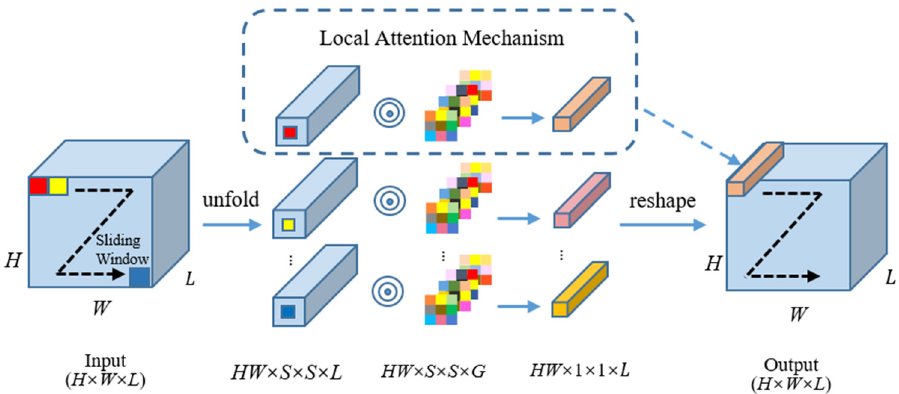
Figure 3. Structure of the LAEM used in DRHAN.